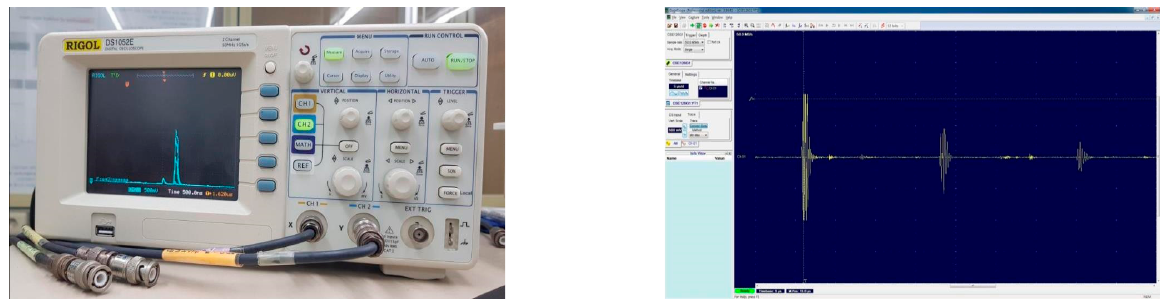
Figure 6. Constructed Activation Module and Data Acquisition System.